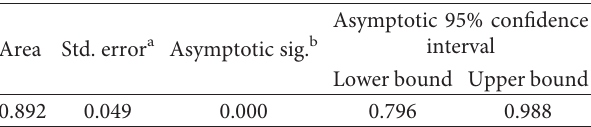
Figure 2: Receiver operator characteristic curve (ROC) for the cold test. Table 6: Area under the curve (AUC) from receiver operator characteristic curve